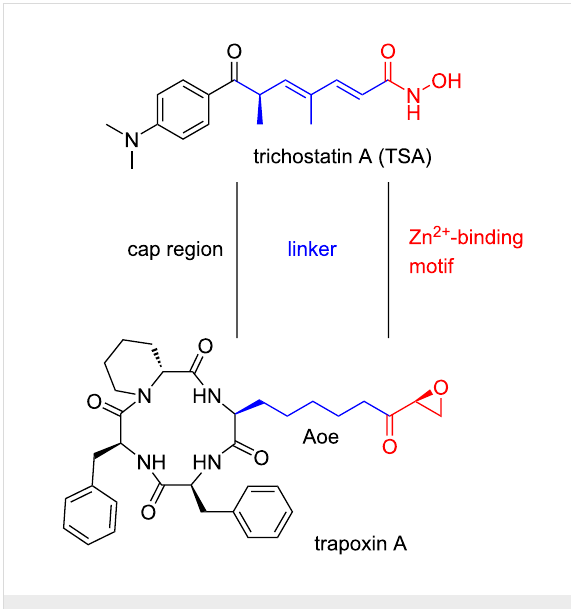
Figure 1: Naturally occurring HDAC inhibitors.